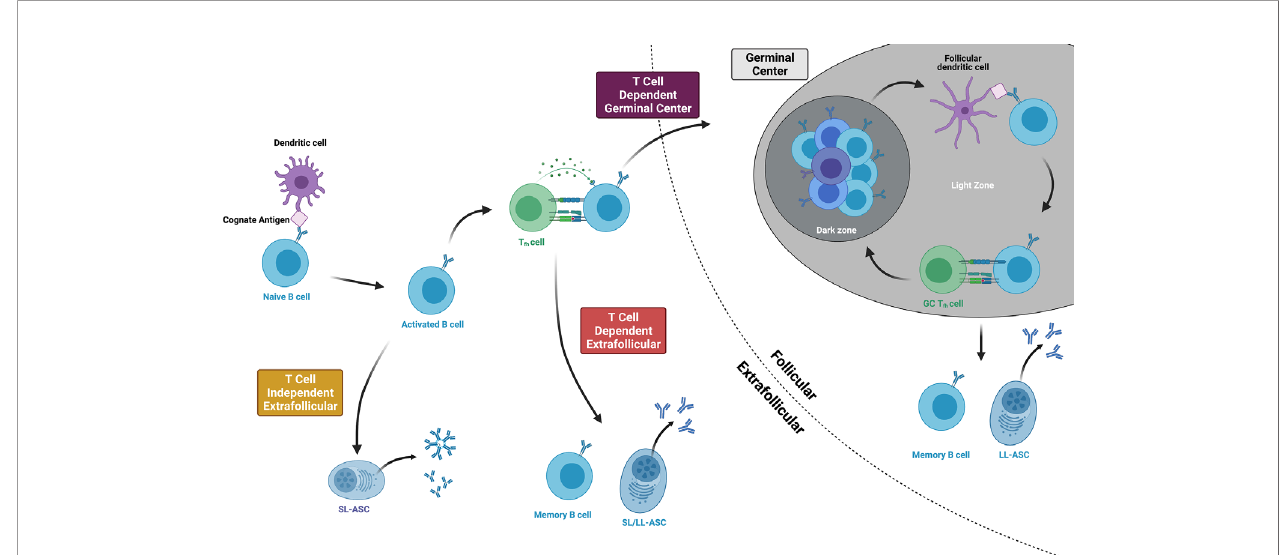
FIGURE 2 | Three main pathways of B cell activation and differentiation. Protein antigens promote T cell dependent responses, culminating in either germinal center or extrafollicular pathways that produce long-lived memory B cells and antibody-secreting cells (ASCs). Within the germinal center, B cells cycle between the dark and light zones, proliferating, mutating, and undergoing af fi nity maturation. T cell independent antigens include mitogens and highly repetitive polysaccharides that can stimulate B cell responses without T cell help. Figure created with